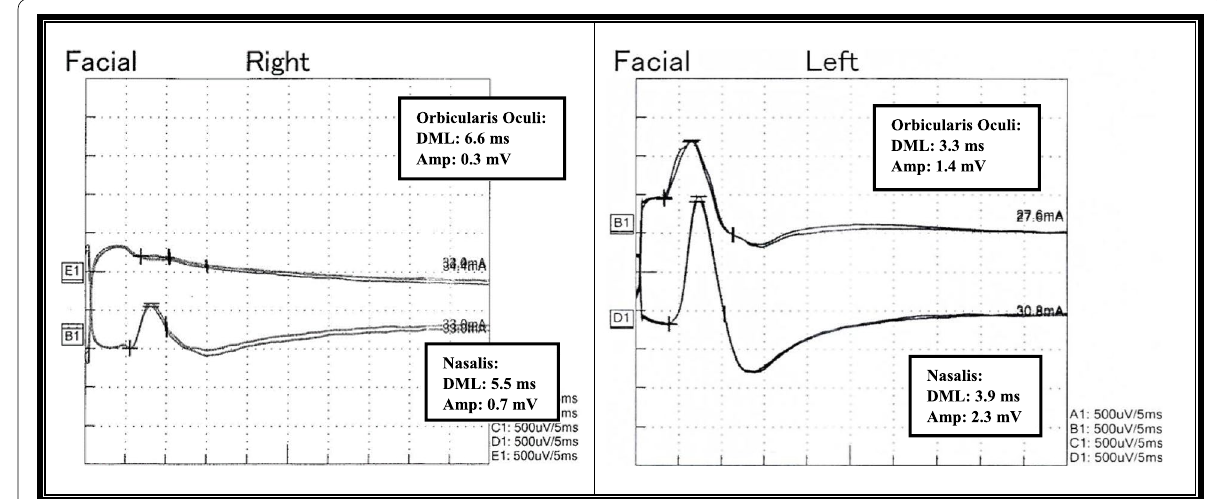
Fig. 2 BR study of a 60-year-old diabetic male patient showing right trigeminal neuropathy (absent right R1, ipsilateral R2, and contralateral R2). R1, early response; R2I, ipsilateral late response; R2C, contralateral late